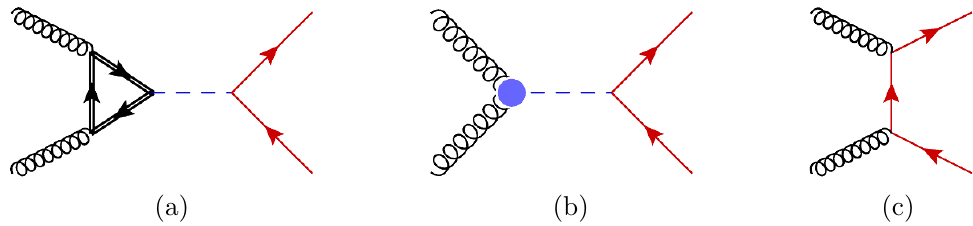
Figure 1 . LO signal and background. Only one diagram from SM background is